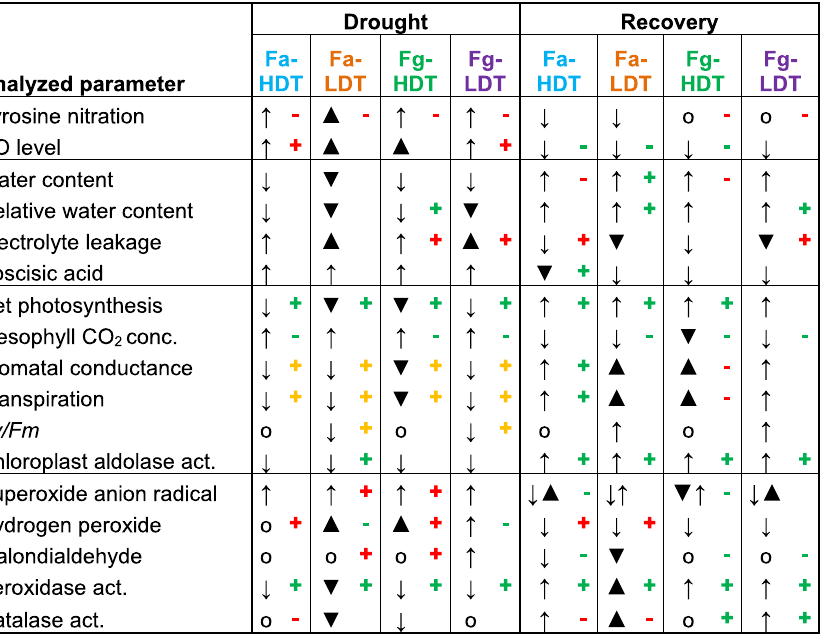
Table 1. Summarized comparison of the most significant changes among analyzed parameters. ( ↓ ) indicates the down-regulation of the parameter; (o) indicates no significant change; (bold arrows) indicates the differences between PTIO non-treated HDT and LDT genotypes; (+ ) indicates the up-regulation effect of PTIO compared to non-treated plants; (−) indicates the down-regulation effect of PTIO compared to non-treated plants; (green) indicates the positive impact of PTIO on plant functioning; (red) indicates the negative impact of PTIO; (yellow) indicates the positive impact on plant productivity but negative on drought tolerance. Conc. concentration, act. activity, PTIO 2-phenyl-4,4,5,5-tetramethylimidazoline-1-oxyl-3-oxide, Fv/Fm maximum quantum efficiency of photosystem